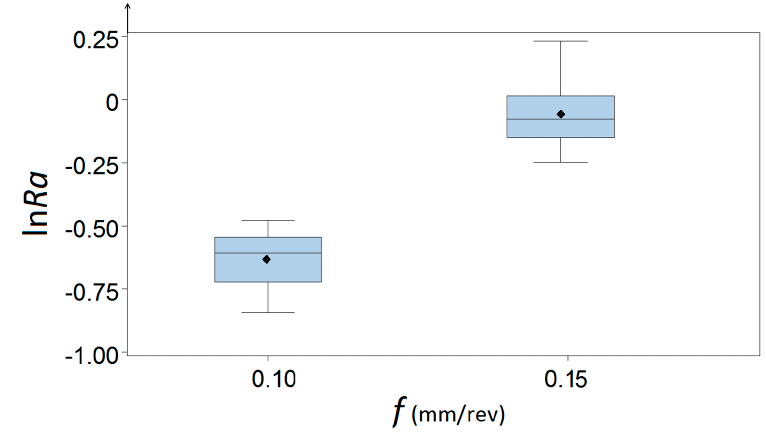
Figure 8. Box and whisker plot with dispersion of ln Ra with respect to the feed rate factor.